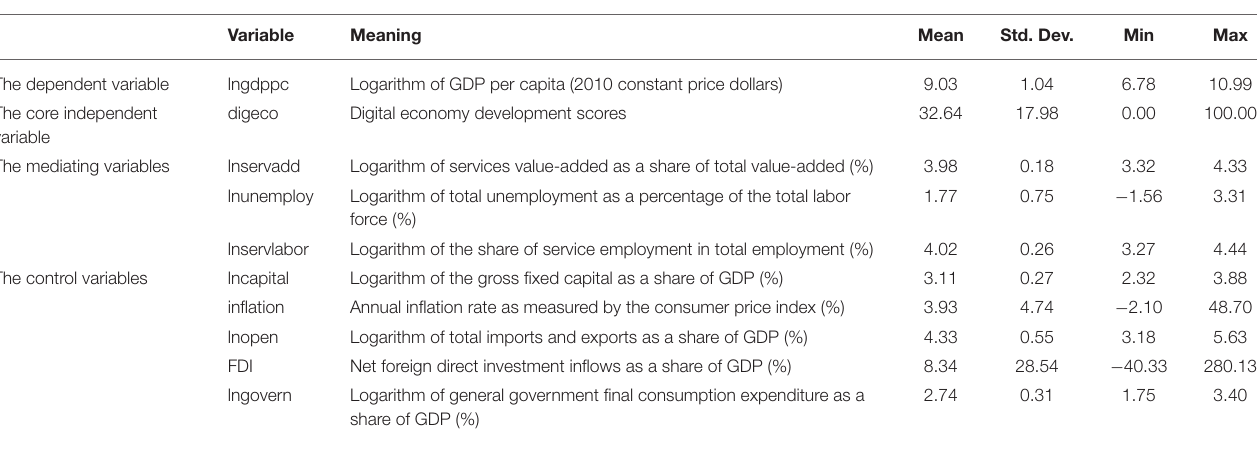
TABLE 4 | Meaning of variables and statistical